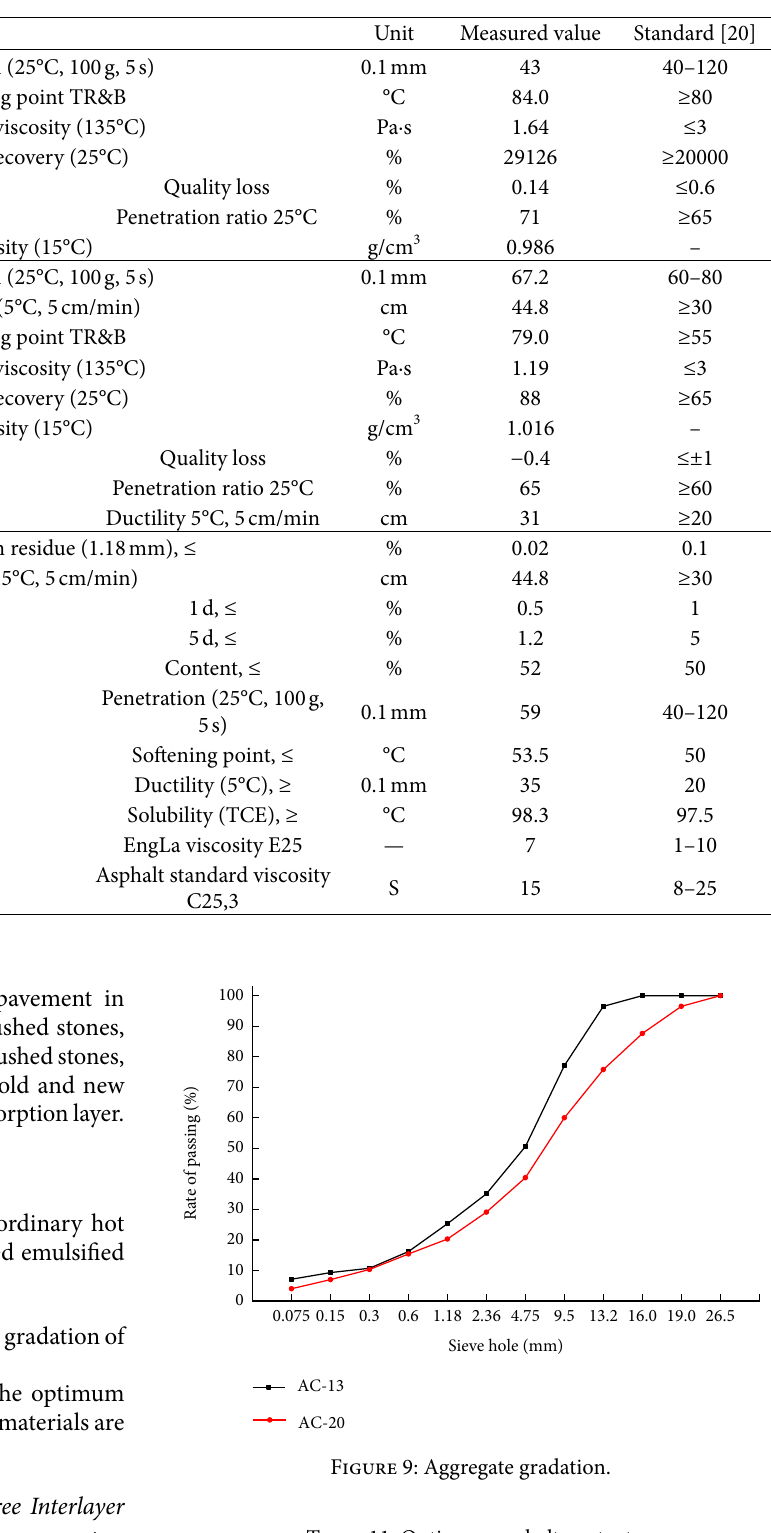
Table 10: Technical specifications of asphalt.